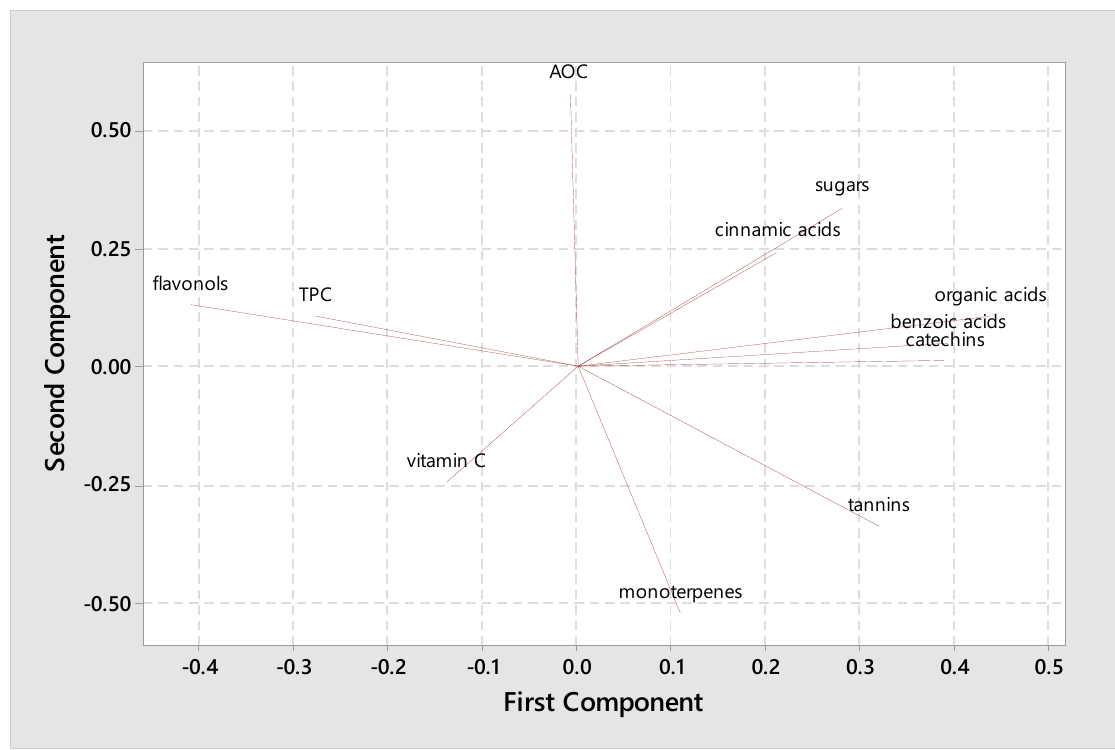
Figure 6. PCA_1 loading plot of the considered variables.